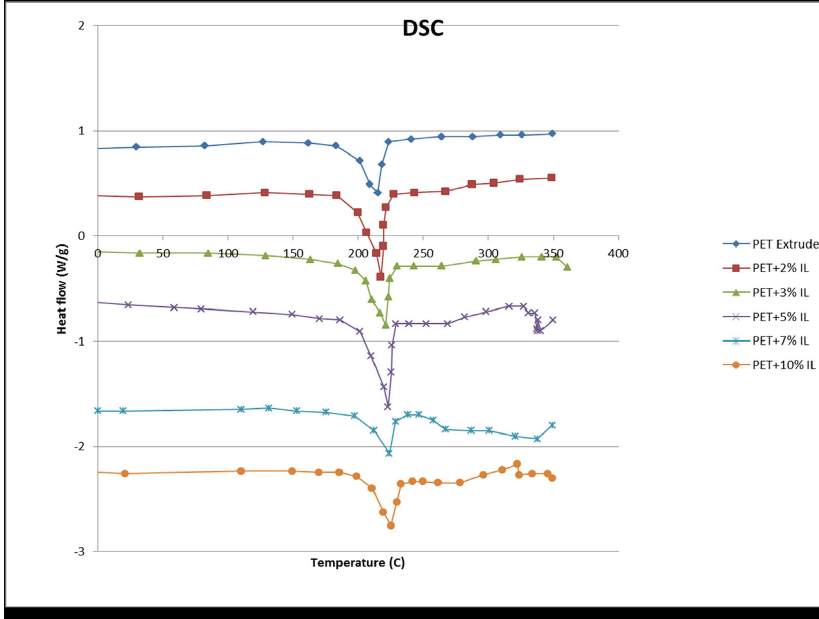
Figure 5. DSC data for prepared PET-IL blends. Table 1. Melting temperatures of prepared PET-IL blends.